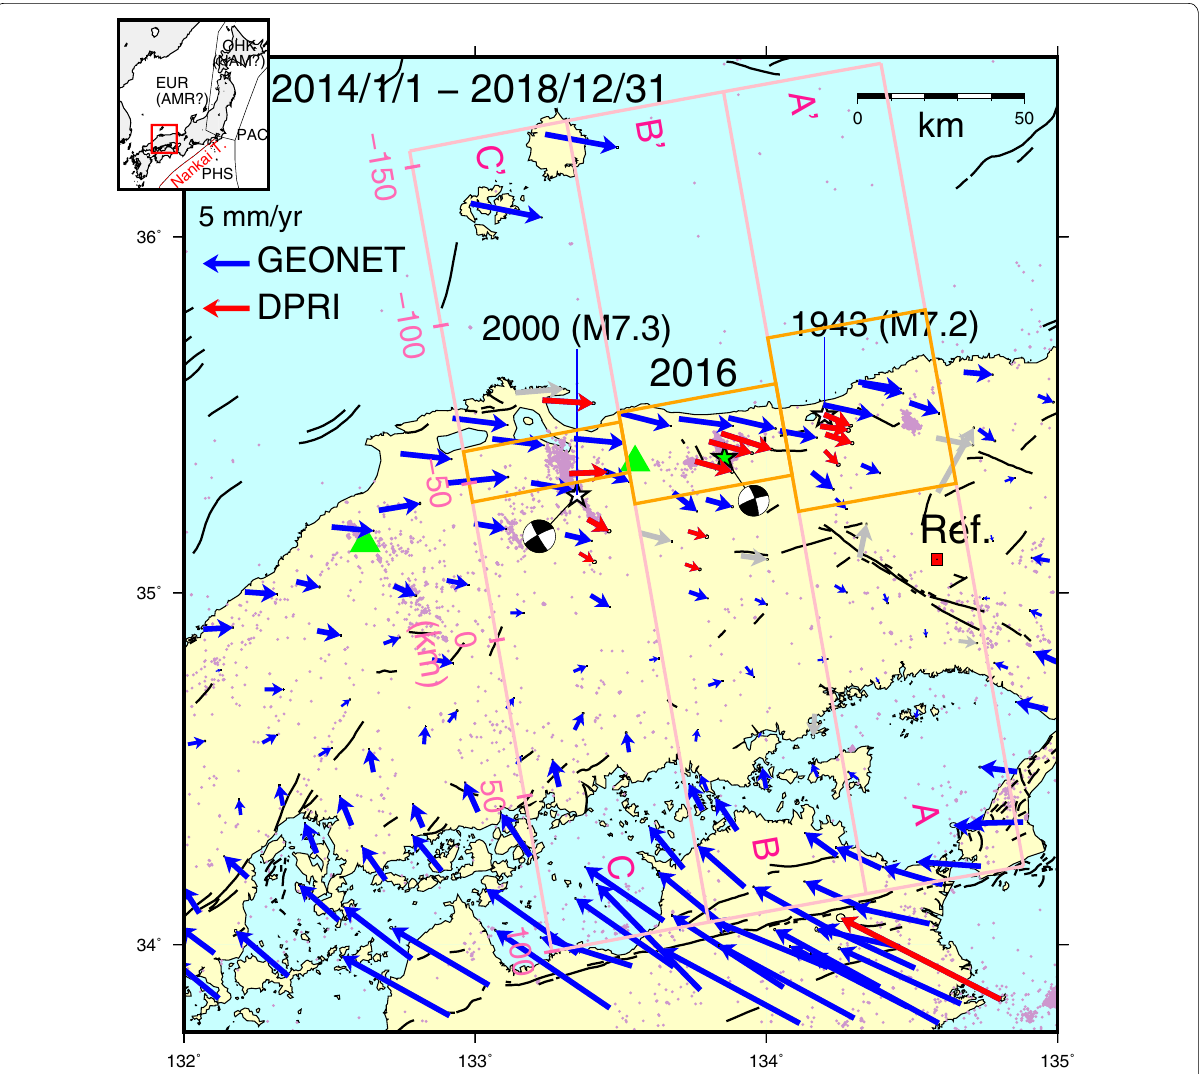
Fig. 1 GNSS velocities in and around the San‑in Shear Zone from January 2014 to December 2018 with respect to station 0344 (red diamond). Blue arrows denote GEONET data, while red arrows Kyoto University data. Gray arrows represent outliers. Thin black lines denote active Quaternary fault traces (Research Group for Active Faults of Japan 1991). Violet dots denote crustal seismicity (depth < 30 km) from 1998 to 2018. Green triangles are active volcanoes within the SSZ. Stars represent the epicenters of the 1943 Tottori, the 2000 Western Tottori and the 2016 Central Tottori earthquakes. Focal mechanisms for the 2000 and the 2016 events are also shown within the figure. The inset figure shows the location of the study area with respect to the Japanese Islands. Three pink rectangles from A–A ′ to C–C ′ indicate locations of velocity profiles in Fig. 2. Ticks on lines in the rectangles are plotted with an interval of 50 km. Orange rectangles denote the optimum widths of the ductile zone in the lower